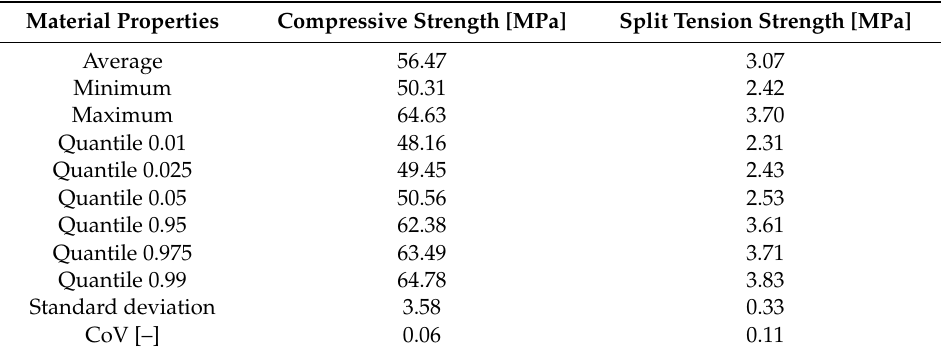
Table 5. Material properties of compressive strength and split tension tests.